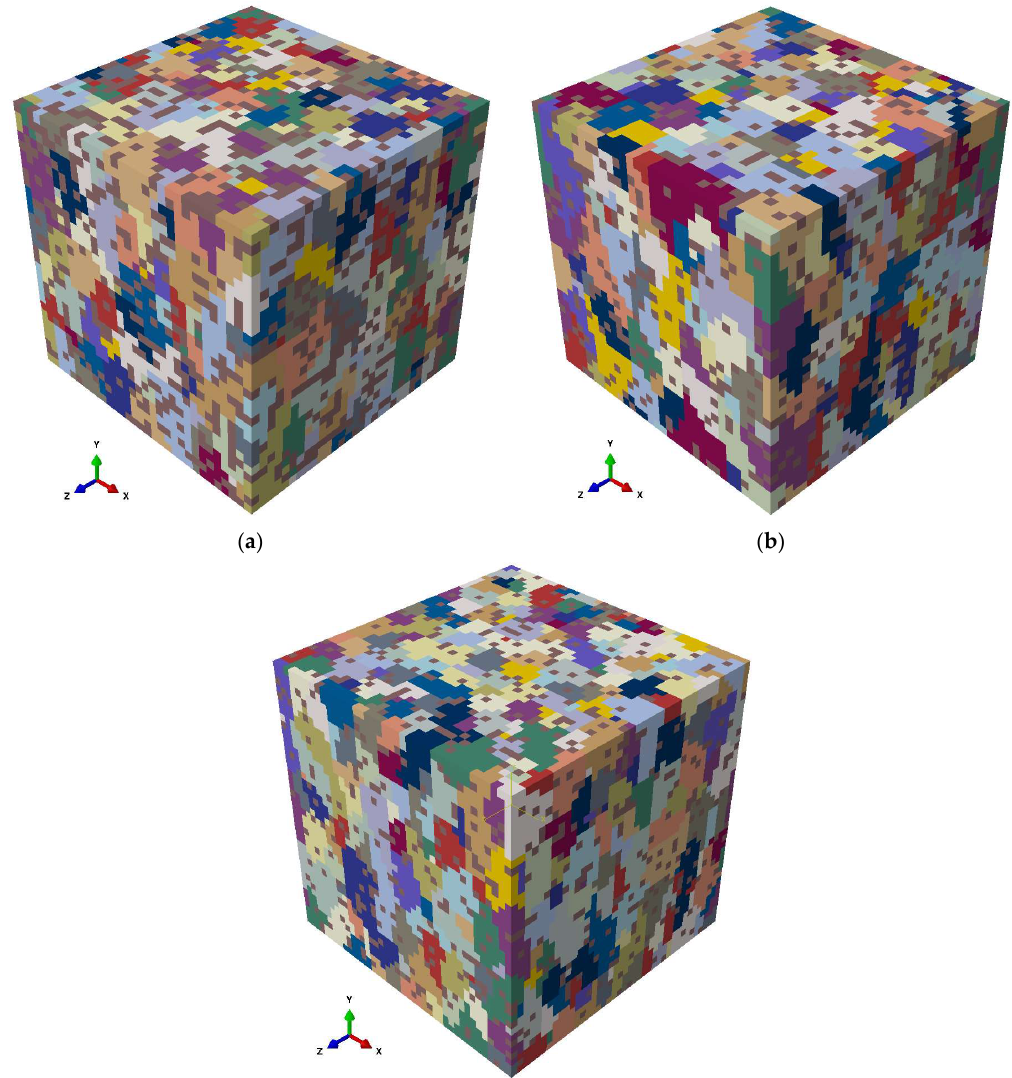
Figure 5. Three-dimensional synthetic mesoscale RVEs of each state generated from the EBSD data of each state using Kanapy with randomly distributed Si-rich phase (shown in brown), ( a ) AB state RVE with 503 grains and 25% volume fraction of Si-rich phase, ( b ) HT1 state RVE with 506 grains and 16.4% volume fraction of Si-rich phase, and ( c ) HT2 state with 502 grains and 11.5% volume fraction of Si-rich phase.